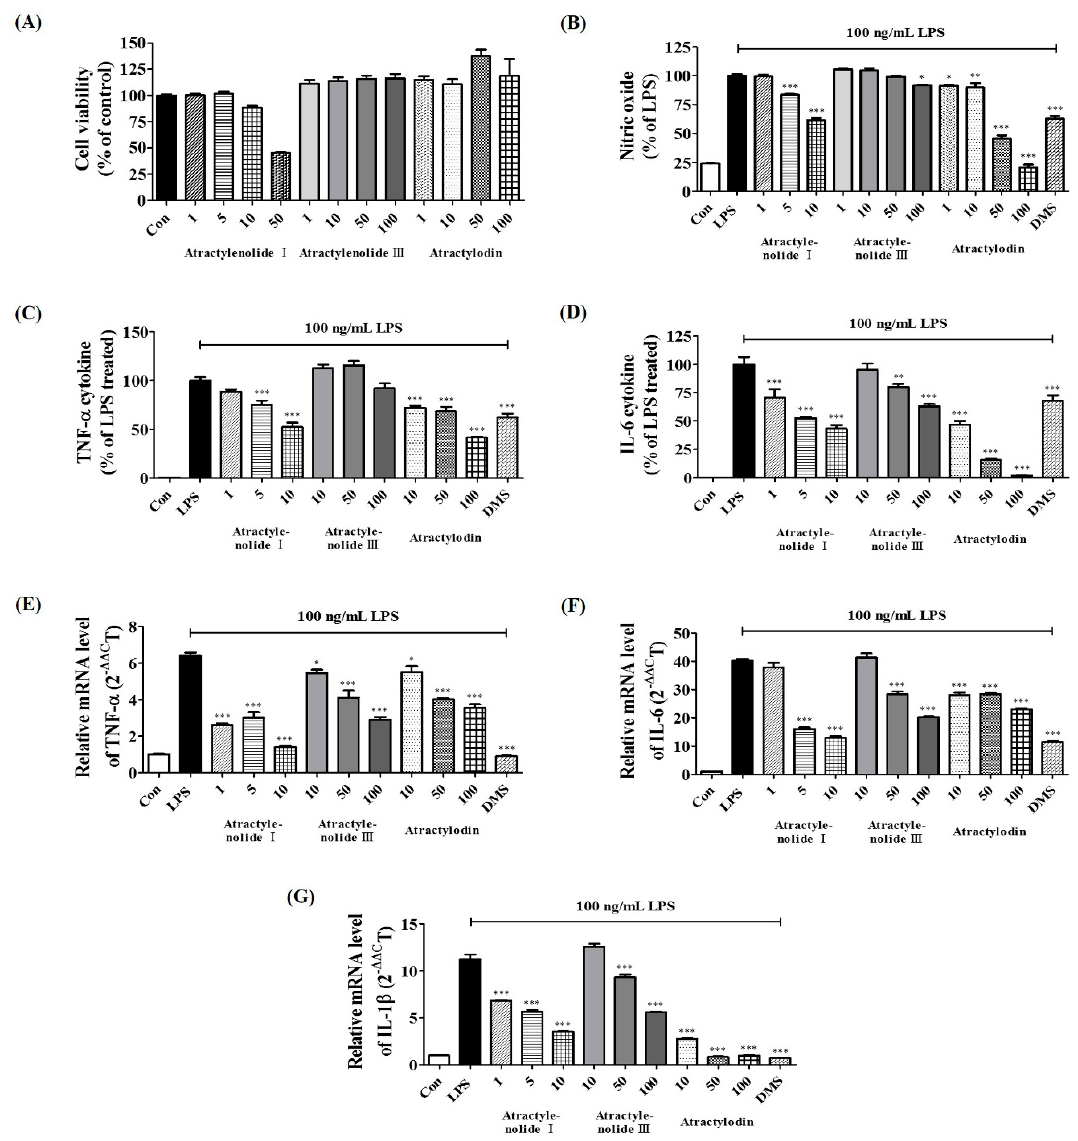
Figure 6. Effects of three compounds—atractylenolide I, atractylenolide III, and atractylodin—on ( A ) cell viability and the production of ( B ) NO, ( C ) tumor necrosis factor (TNF)- α , ( D ) interleukin (IL)-6 cytokines, and ( E – G ) cytokine mRNAs. Cells were seeded on a culture plate and pre-incubated for 18 h. Control cells were incubated with vehicle alone. Data represent the mean ± SEM of duplicate determinations from three independent experiments. Con: control; LPS: lipopolysaccharide; DMS: 10 µ M dexamethasone. * p < 0.05; ** p < 0.001; *** p < 0.0001.